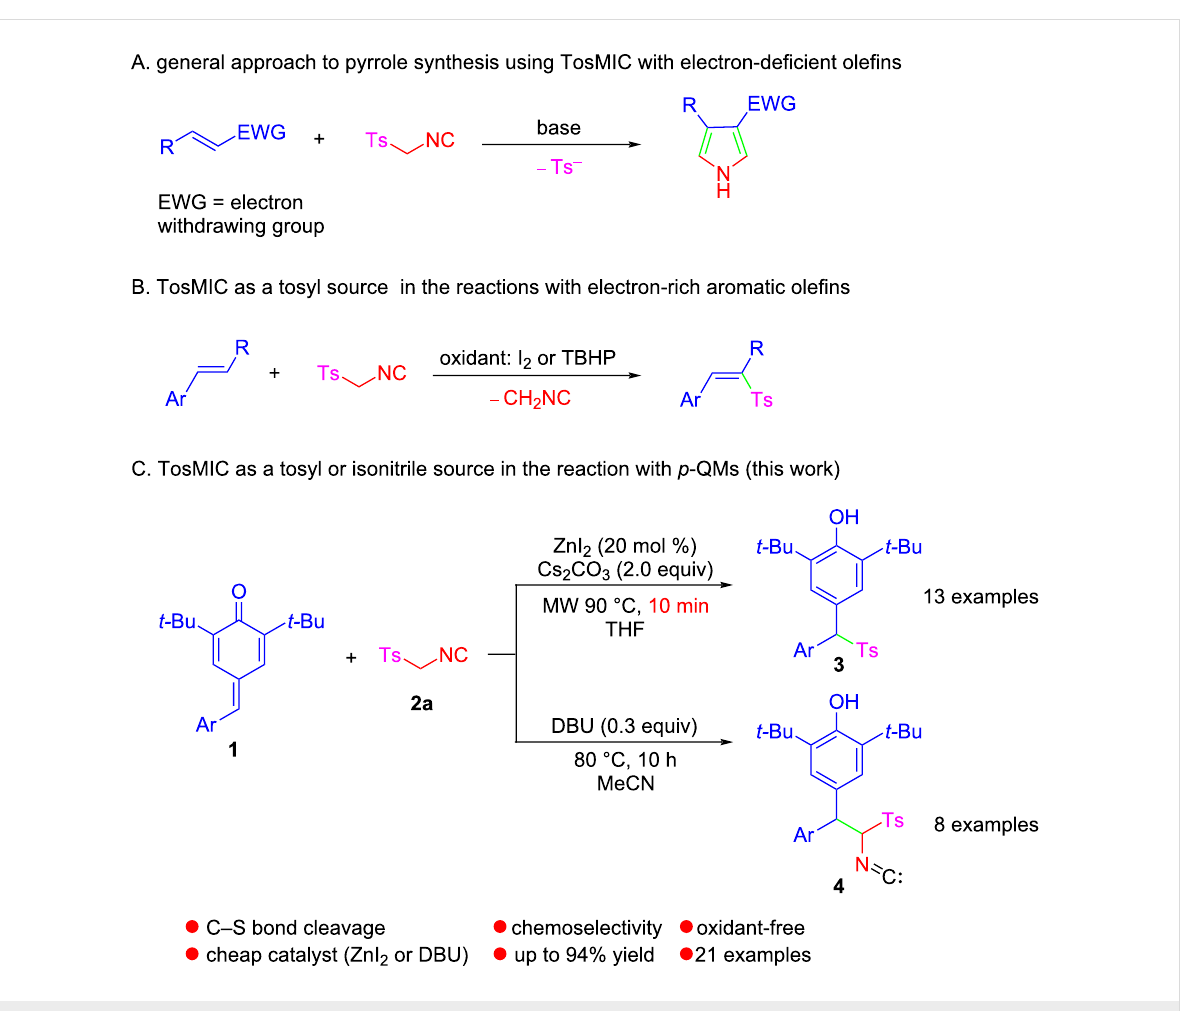
Scheme 1: The chemistry of TosMIC in the reactions with